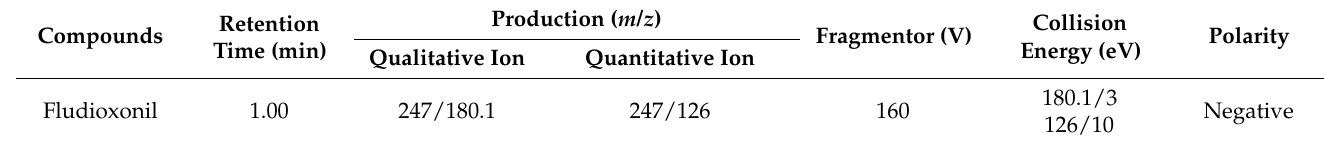
Table 1. Acquisition parameters of fludioxonil in multiple reaction monitoring (MRM)